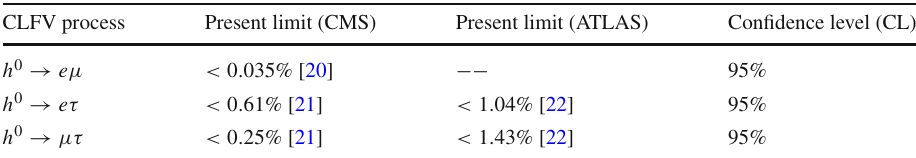
Table 1 Present experiment CLFV process Present limit (CMS) Present limit (ATLAS) limits for 125 GeV Higgs decays h 0 → l i l j with the CLFV